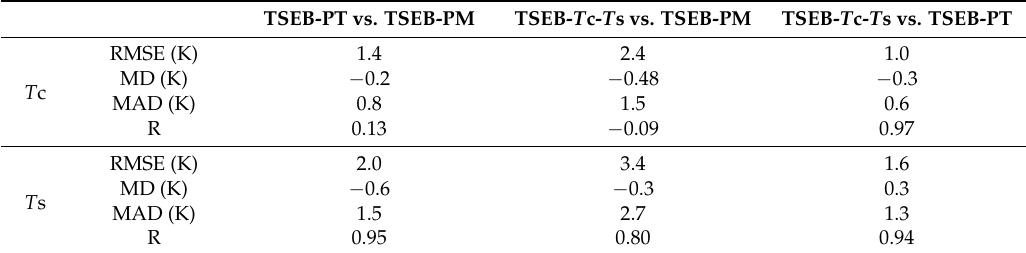
Table 3. Statistics summarizing the intercomparison of T C and T S derived from TSEB-PT, TSEB-PM, and TSEB- T C - T S in the kernel experimental area.